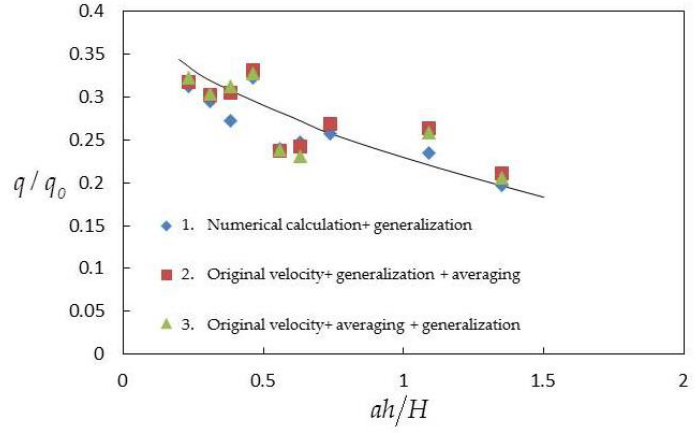
Figure 16. Ratio of single-width-discharges q/q 0 varies with the comprehensive parameter ah/H . (3 cases).